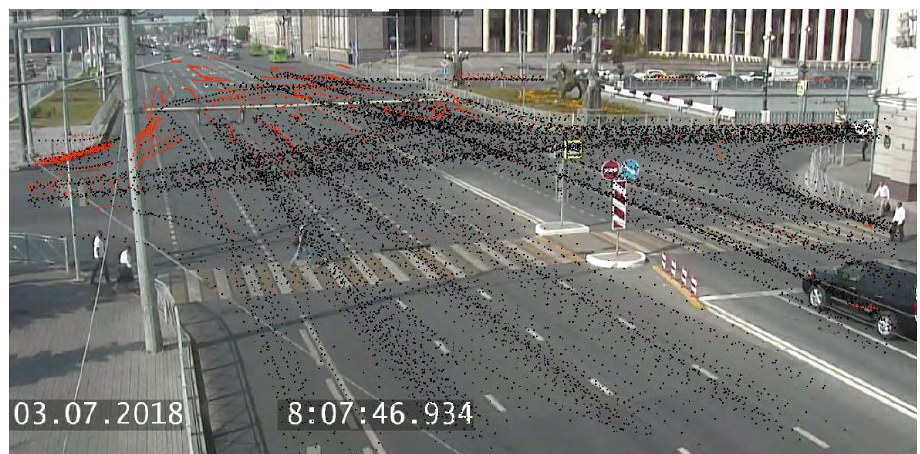
Figure 5. Results of trajectories filtering.